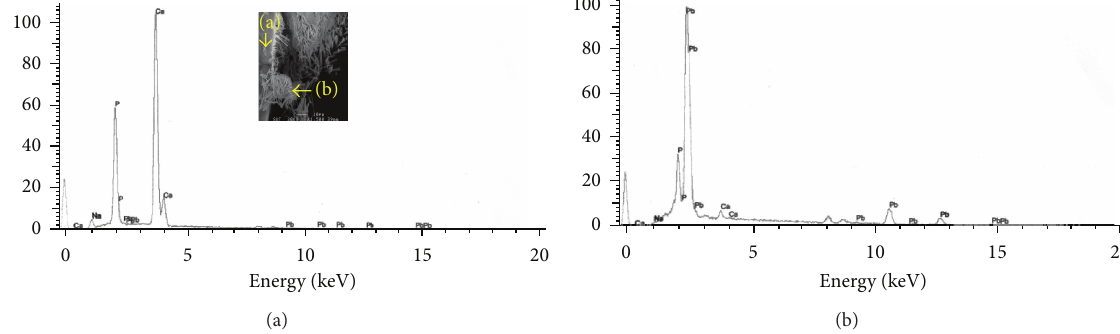
Figure 4: EDX spectra of products after refluxing in lead nitrate solution (917 mg/L) for 24 h. (a) CaHAp substrate and (b) PbHAp needle-like crystal product region. The inset shows the locations sampled for the spectra.